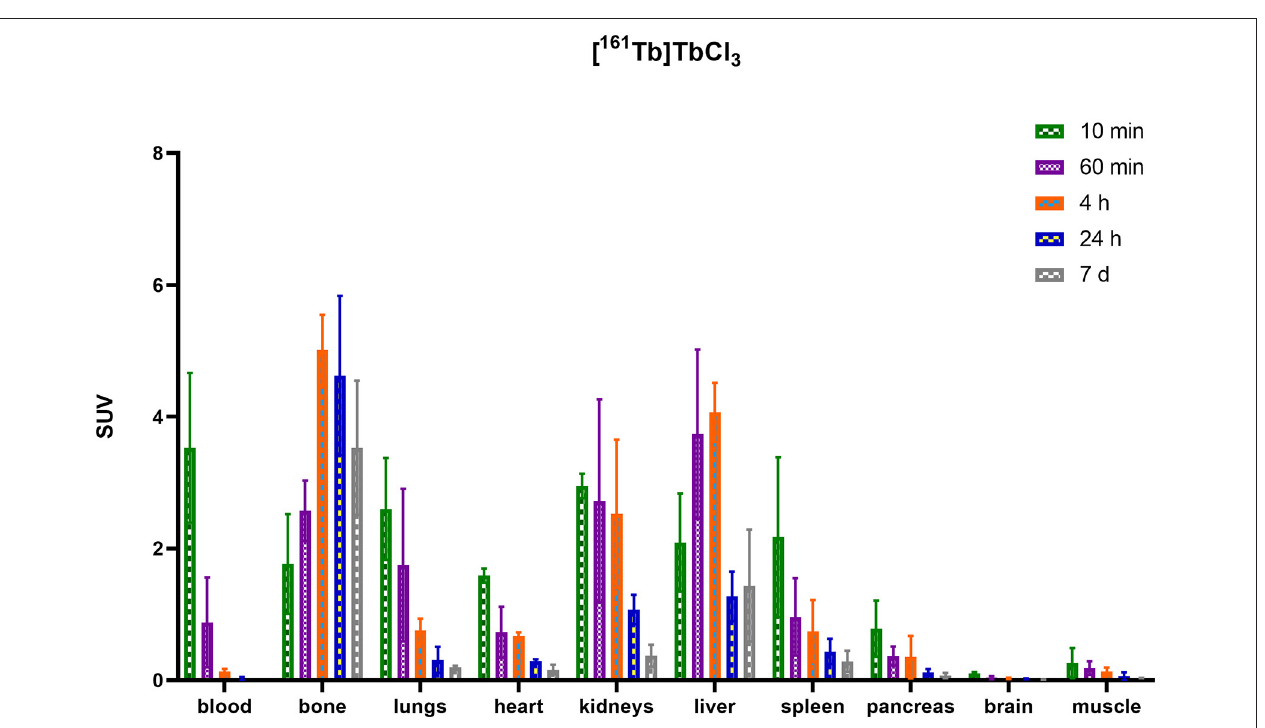
Frontiers in Medicine |